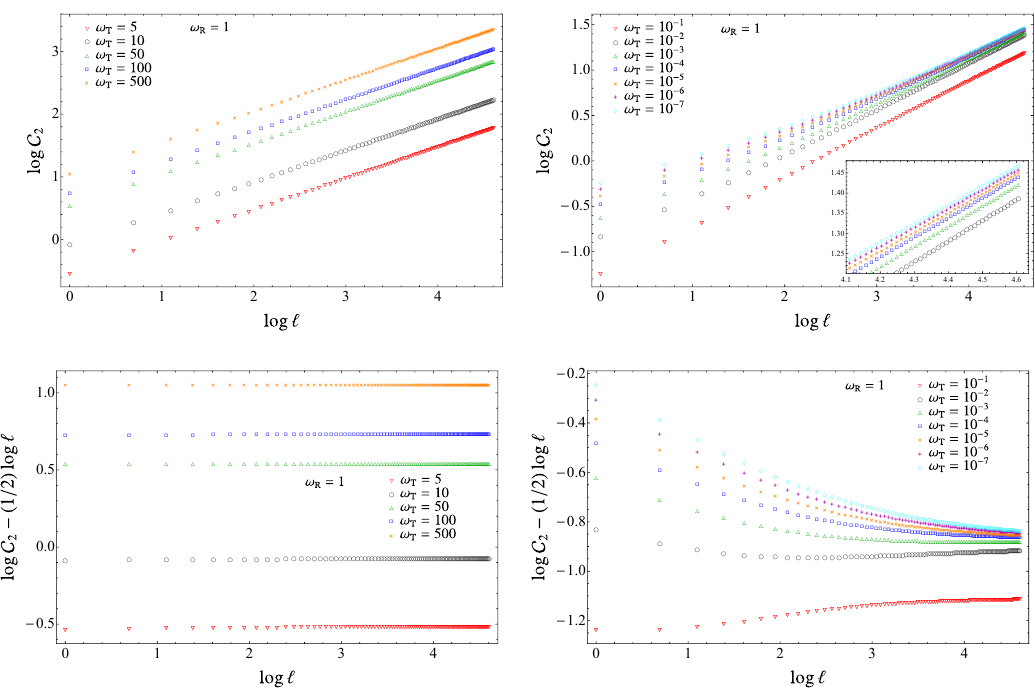
6 = ω . Here κ = m = 1 ; hence ˜ ω = ω R T R R : ω > ω in the left panels and T T R